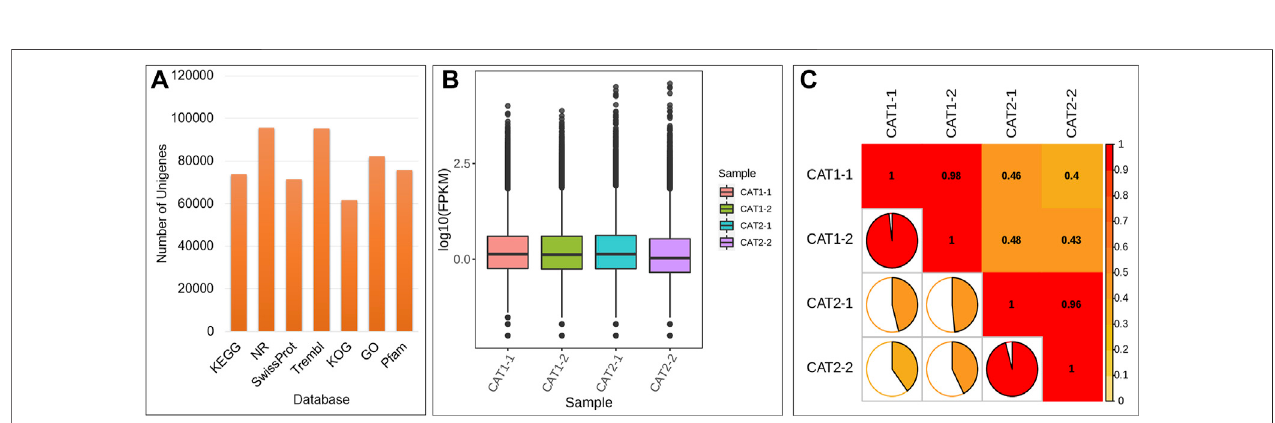
FIGURE 2 | (A) Summary of unigene annotation in different databases, (B) overall distribution of sample gene expression, and (C) Pearson correlations between CAT-1 (CMCs) and CAT-2 (DDCs).